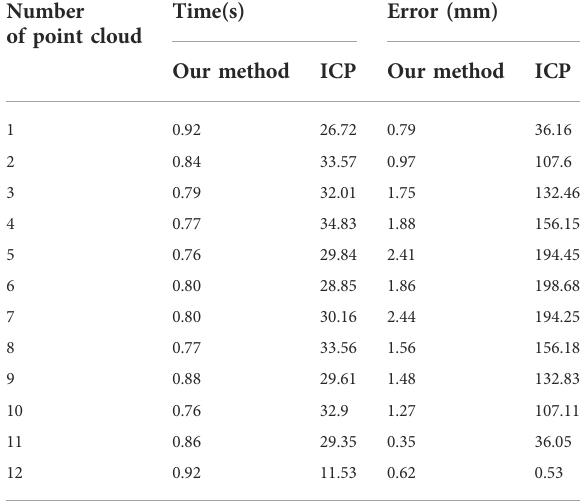
TABLE 1 Rotation and translation parameters of point cloud B. The serial number